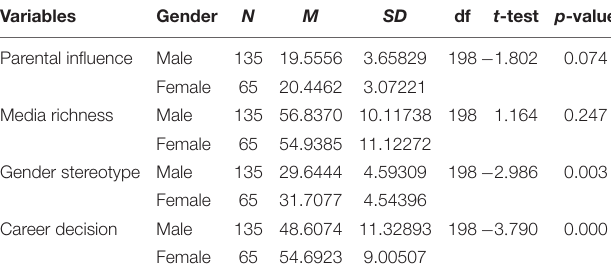
TABLE 5 | Mean, standard deviation, t -value, and scores of parental influence, media richness, gender stereotype, and career choice among students ( N =